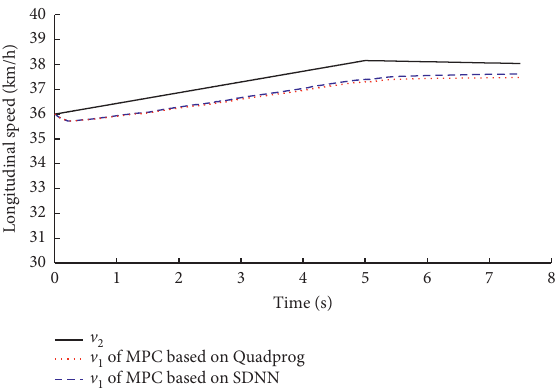
Figure 28: Longitudinal speeds of the LV and the FV of two controllers.